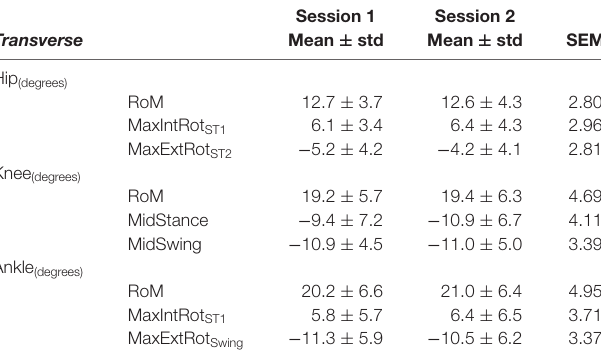
TABLE 5 | Transverse plane variables—Self-Selected Walking Speed: mean ± standard deviation (std) for Session 1 and Session 2, and Standard Error of Measurement